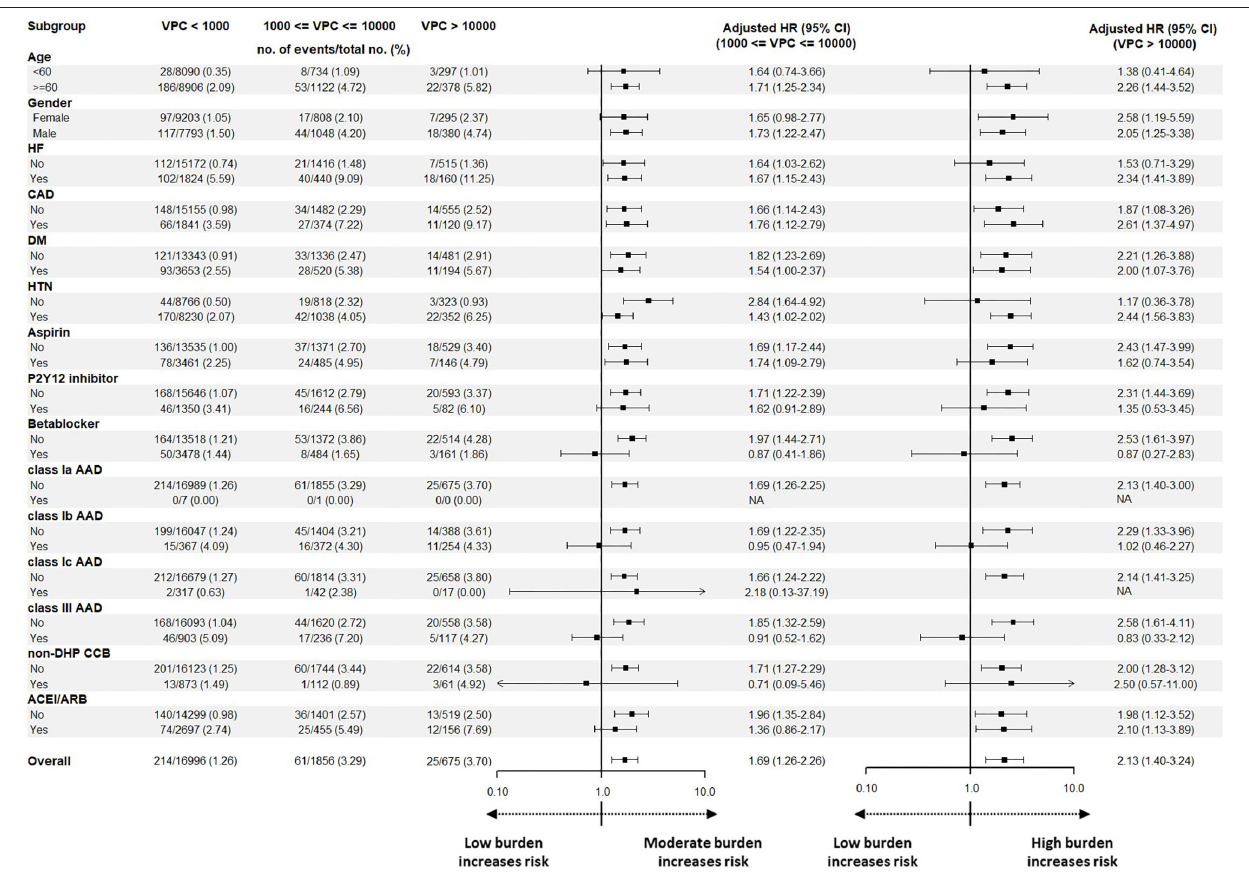
FIGURE 4 | A subgroup analysis before the propensity match analysis for analyzing the effect of baseline characteristics, underlying disease, and medication on cardiovascular death. Illustration of the subgroup analysis before the propensity score match analysis. Male, elderly, patients without hypertension or DM, and patients who did not use P2Y12 inhibitor, beta blocker, non-DHP CCB, ACEI/ARB, or AADs showed an increased risk to have cardiovascular death in comparison with the low burden group. Regarding the high burden group, the elderly, patients with HF and hypertension, and patients who did not use aspirin, beta blockers, non-DHP CCB, or AADs showed an increased risk to have cardiovascular death in comparison to the low burden group. AAD, antiarrhythmic drug; ACEI/ARB, angiotensin-converting enzyme inhibitor/angiotensin receptor blocker; CAD, coronary artery disease; CI, confidence interval; DM, diabetes mellitus; HF, heart failure; HTN, hypertension; non-DHP CCB, non-dihydropyridine calcium channel